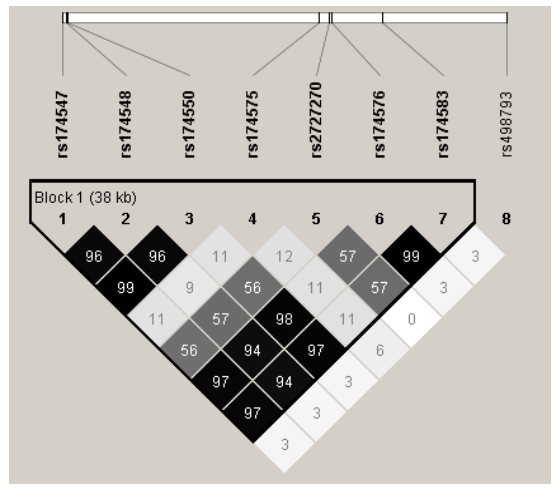
Figure 1. Linkage disequilibrium (LD) block generated by the 8 FADS 1 and FADS 2 polymorphisms genotyped, with pairwise r 2 values and color